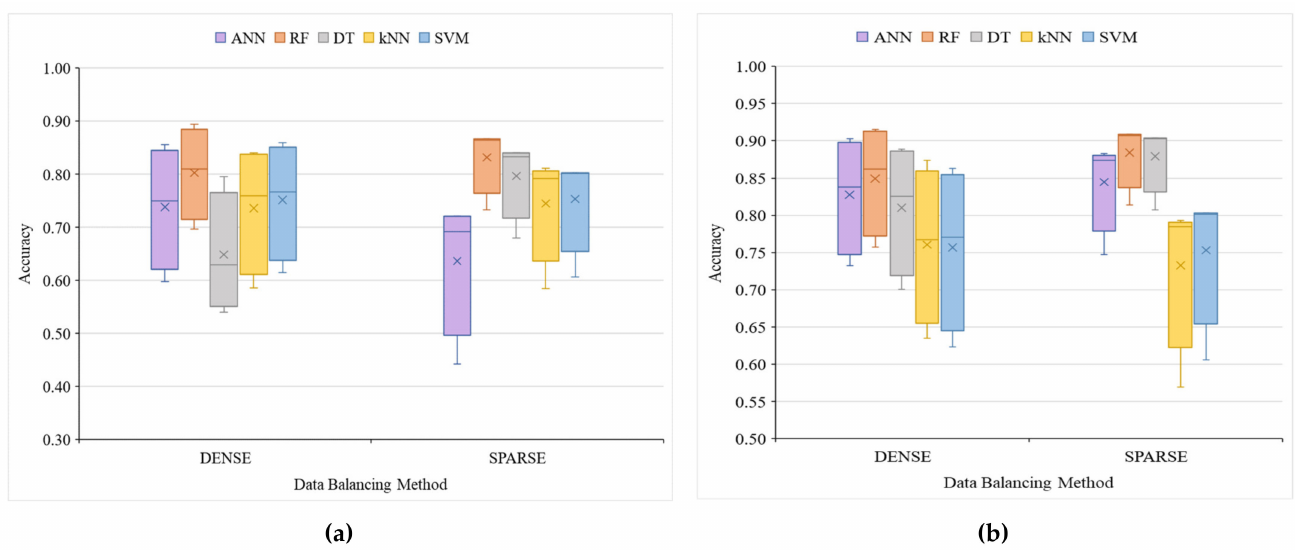
Figure 6. Assessment of DENSE and SPARSE data balancing methods using different machine learning models. The accuracy refers to the total combination of four multi-metrics including OA, Kappa Index, F1-score, and AUROC. ( a ) Default parameters, and ( b ) optimal parameters.